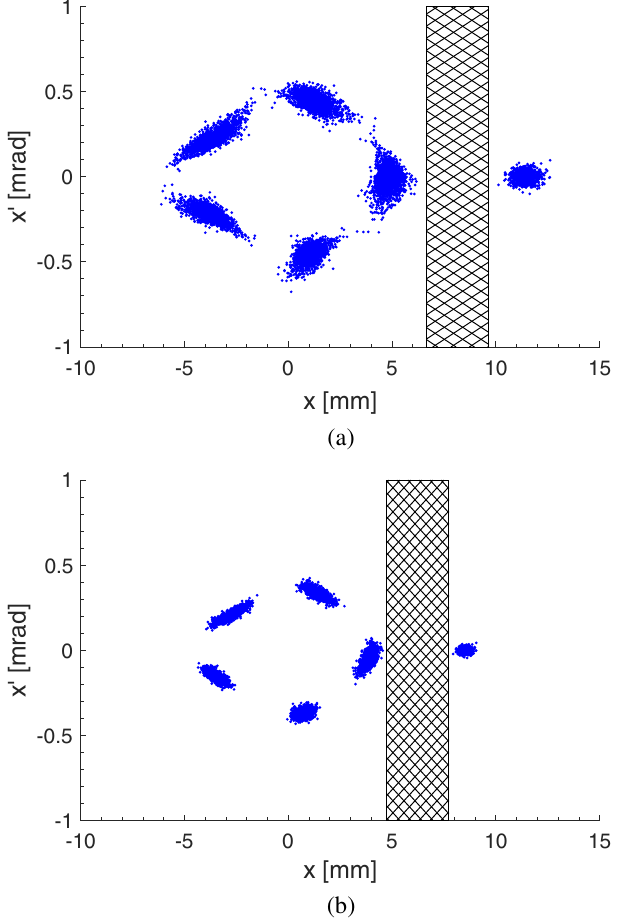
FIG. 3. Tracking simulations of a multipole kicker injection based on a pulsed sextupole magnet with and without emittance exchange. The first 10 turns in the machine are included. (a) Horizontal phase space (b) vertical phase space. The lower horizontal emittance due to emittance exchange significantly reduces the smear of the injected beam in the horizontal phase space arising from the kicker magnet defocusing and the strong lattice